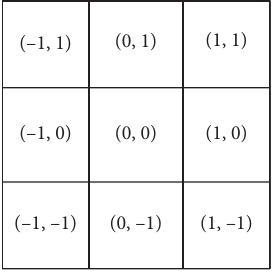
Figure 5: Gaussian